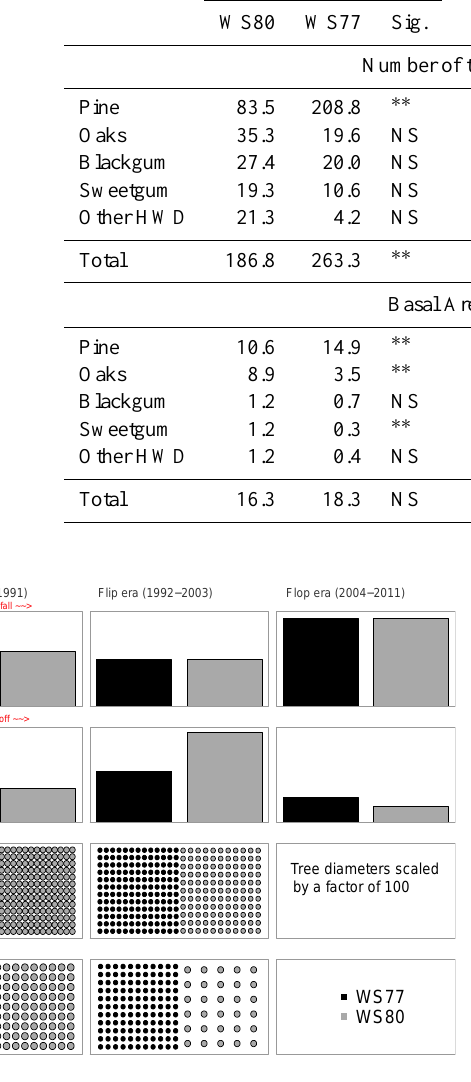
Fig. 7. Changes in rainfall, runoff and forest structure in WS77 and WS80 before (pre era) and after Hugo (flip and flop eras). Lower four panels show the number of all trees or only pine trees (lowest row) within a 1-ha plot. Tree diameters are scaled by a factor of 100. The sum of shaded areas in each watershed represents a consistently scaled approximation of basal area per hectare before (pre era) and after (flip era) Hugo. Refer to Table 2 for more details.